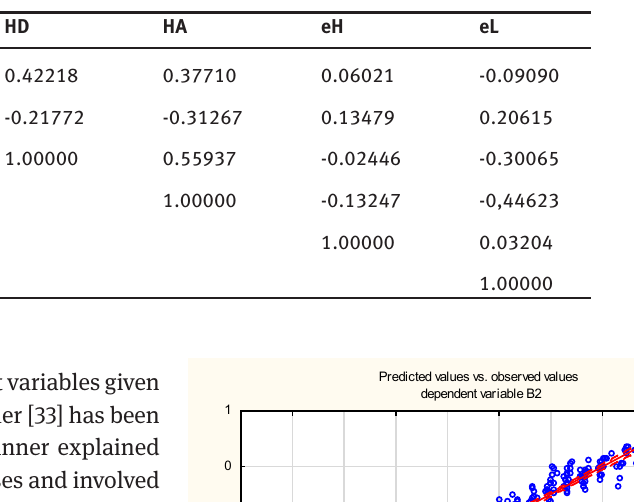
Table 3: Correlation matrix for models ( 10) and (11).